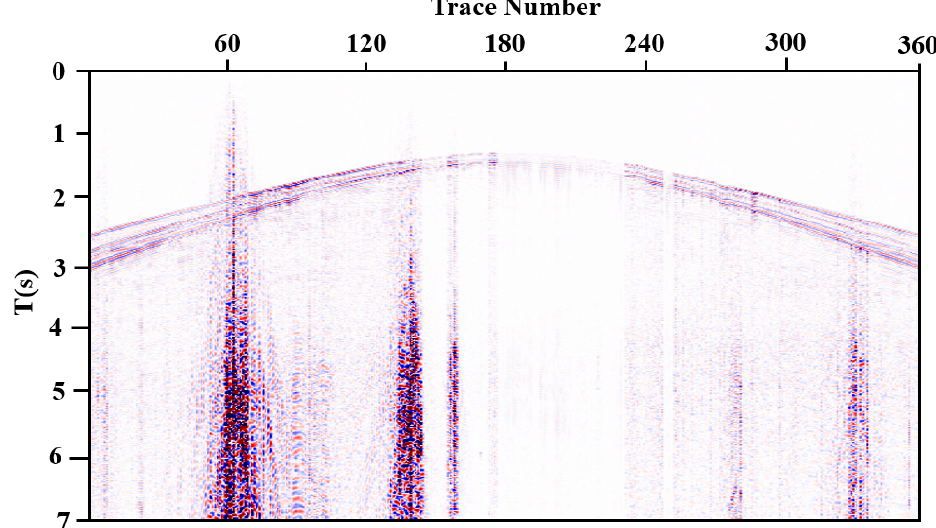
Figure 12. The original data with traffic